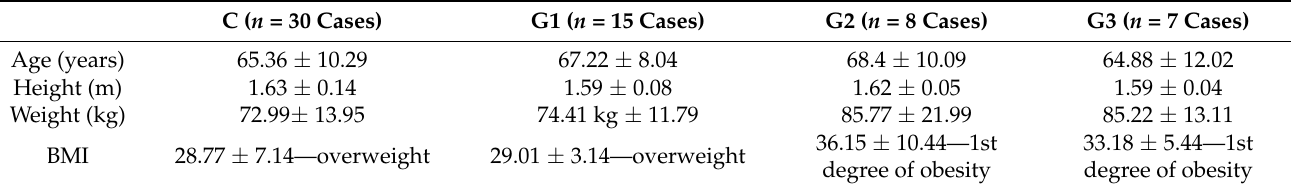
Table 1. Characteristics of patients included in a control and a study